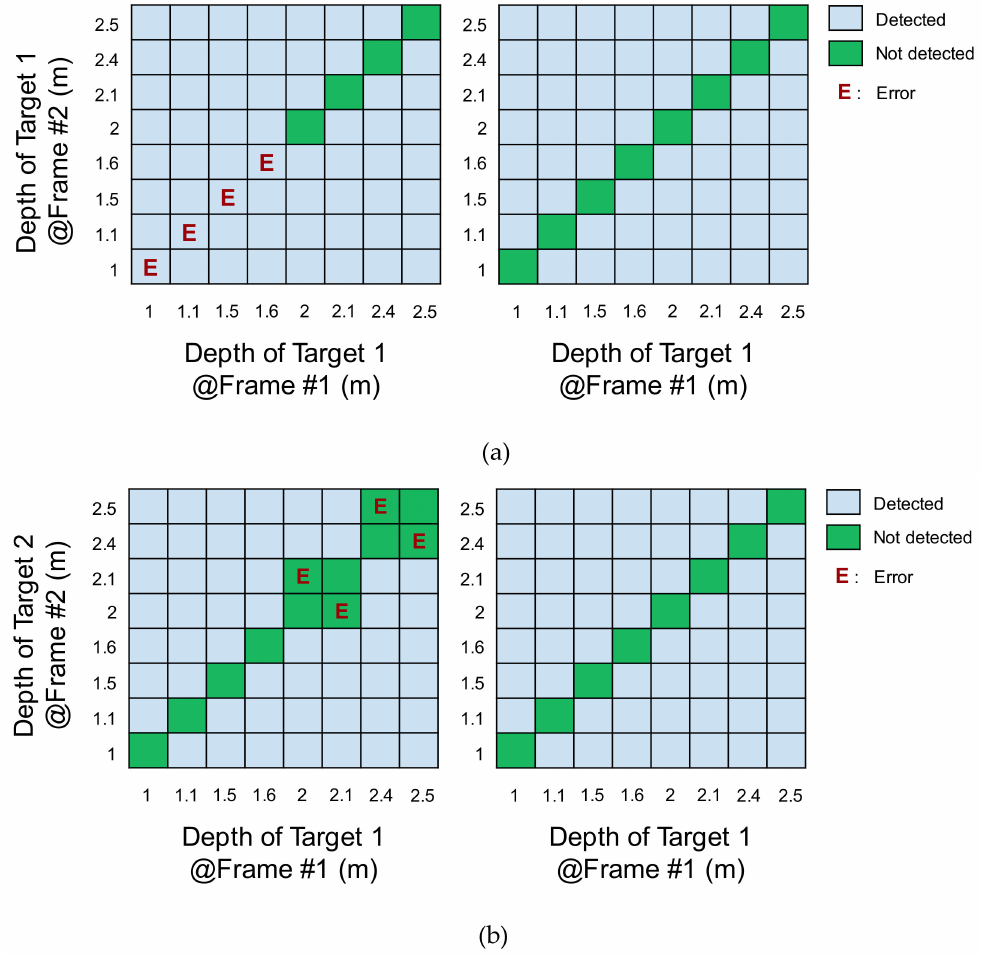
Figure 13. Comparison of depth frame di ff erence results without two-step comparison (left) and with proposed circuit (right): ( a ) di ff erence depth with same targets (Frame #1: Target 1(2), Frame #2: Target 1(2)); ( b ) di ff erence depth with di ff erent targets (Frame #1: Target 1(2), Frame #2: Target